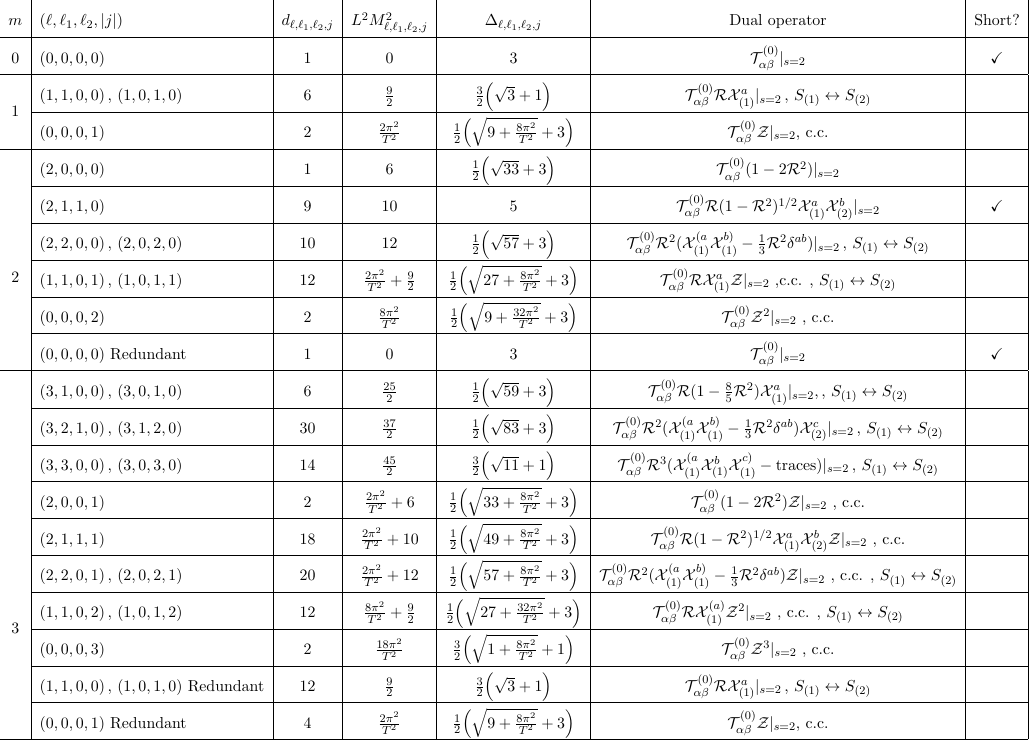
Table 5 . The spin-2 spectrum of the N = 4 S-fold solution. We have employed the notation R 2 = (cid:14) ab X a X b and S $ S means exchange of the labels (1) and (2), and simultaneously (1) (2) (1) (1) R 2 $ 1 (cid:0) R 2 . The spectrum is organised in SL(8) KK levels (see section 5) m = 0 ; 1 ; : : : , and this leads to some redundant states as discussed in that section. The dual operators are single-trace. The tr symbol has been